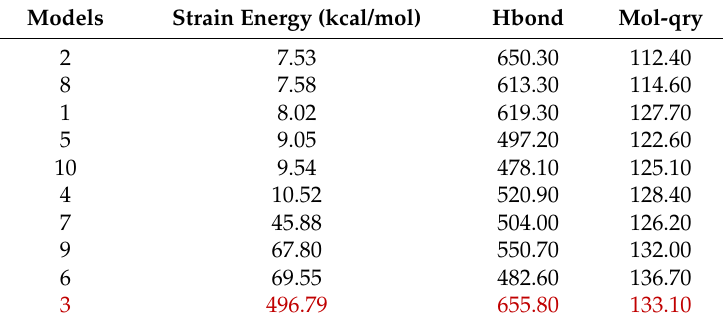
Table 1. Parameters of GALAHAD™ for models from MtKasA inhibitors. The pharmacophore model that presented an energy penalty is indicated by the red